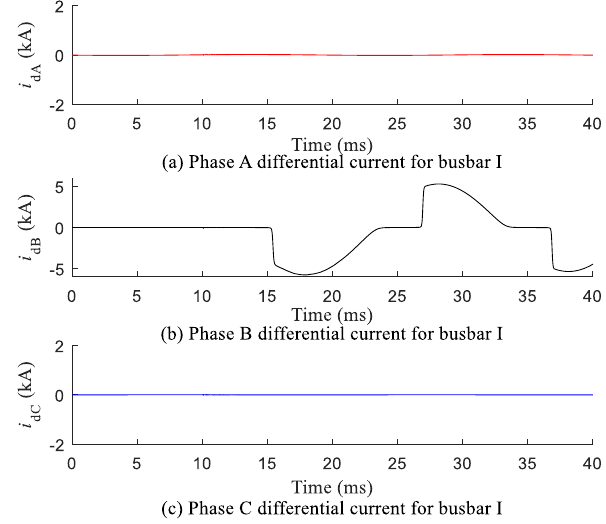
Figure 12. Differential current of busbar I, on the condition of the phase B saturation of CT 3 .